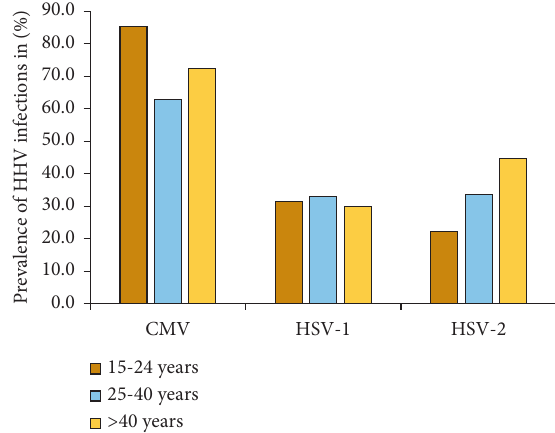
Figure 3: Distribution of HHV coinfections among different age groups in key population groups. The figure depicts the distribution (frequency) of HHVs (CMV, HSV-1, and HSV-2) coinfections among the key populations with reference to age